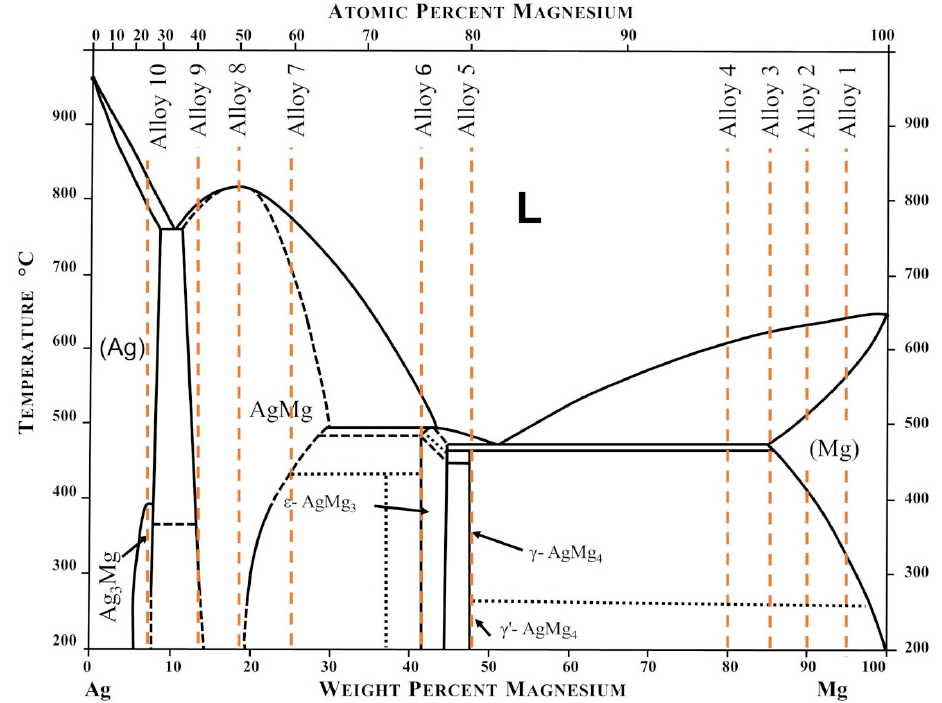
Figure 1. Representation of the chemical composition of the fabricated Mg-Ag samples on the Ag-Mg phase diagram. Diagram based on [16]. Table 1. Specification of the applied materials.